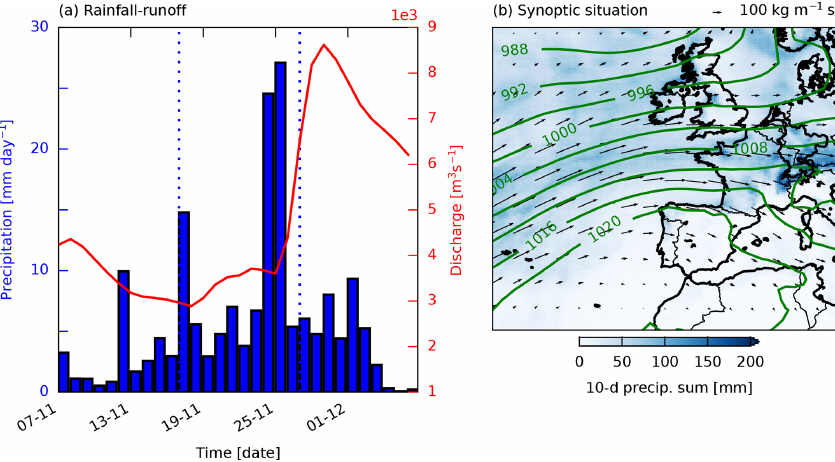
Figure 9. In (a) precipitation (in blue) and discharge (in red) for the Rhine are shown 20 days before and 10 days after the selected event. The vertical dotted lines indicate the 10-day period, which is spatially summed in (b) . The contour lines in (b) indicate the 10-day-averaged mean sea level pressure in hPa and the arrows the 10-day-averaged vertical integrated moisture fluxes in kgm − 1 s − 1